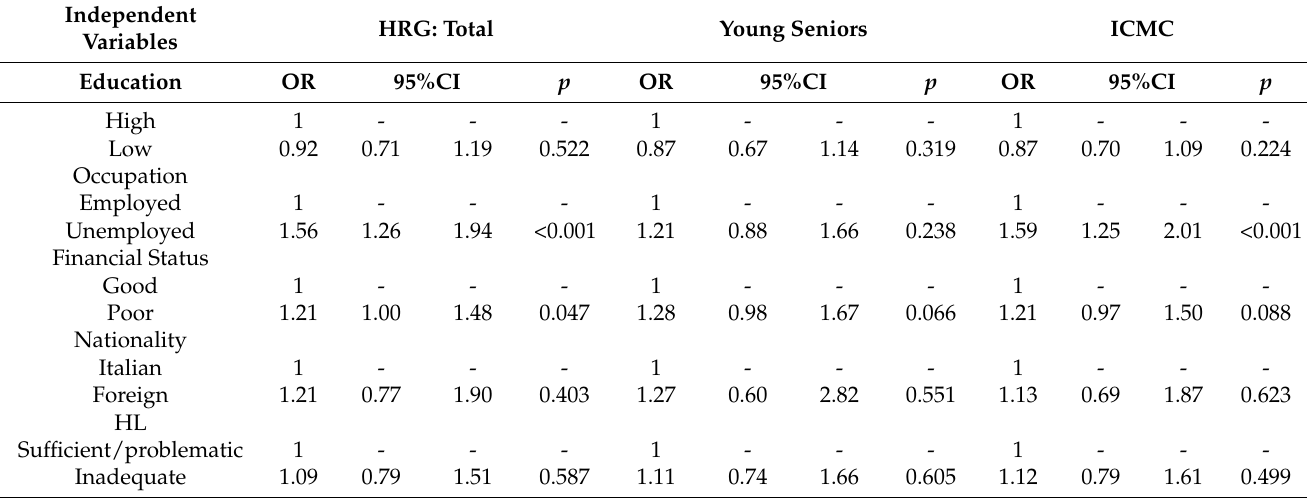
Table 3. Outcome Models: association (logistic regression analysis adjusted for age and sex) between influenza vaccination status (vaccinated vs. not vaccinated; dependent variable), SES factors (ed- ucation, occupation, financial status, nationality) and Health Literacy (independent variables) in high-risk groups (total, young seniors, and individuals with chronic medical conditions). HRG: high risk group; ICMC: individuals with chronic medical conditions; OR: Odds Ratio; CI: Confidence Interval. SES: socioeconomic status.